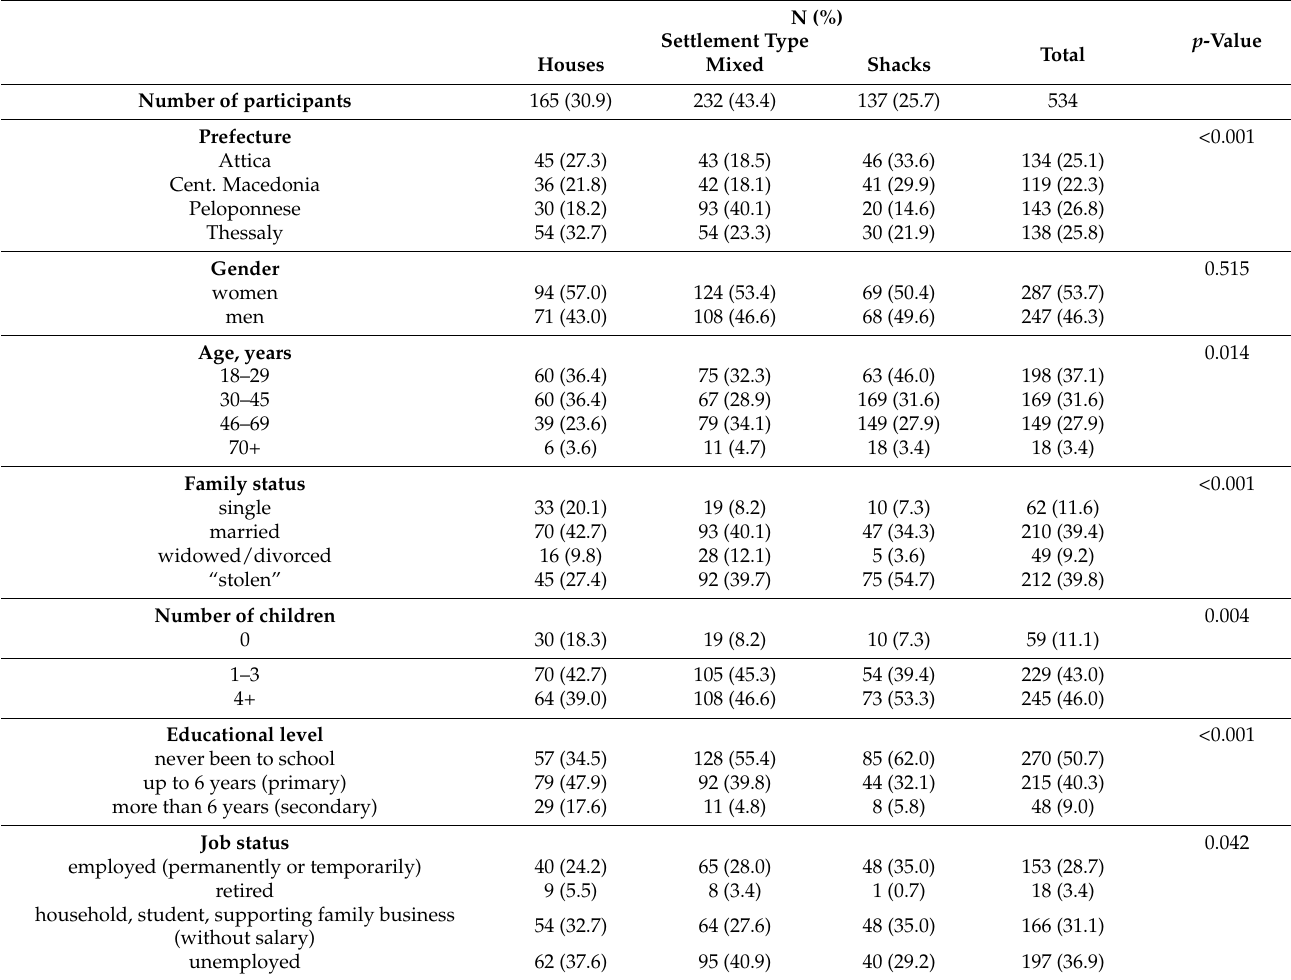
Table 1. Socio-demographic characteristics and behavioral risk factors of Roma living in Roma settlements in Greece by settlement type (houses, mixed, and shacks).